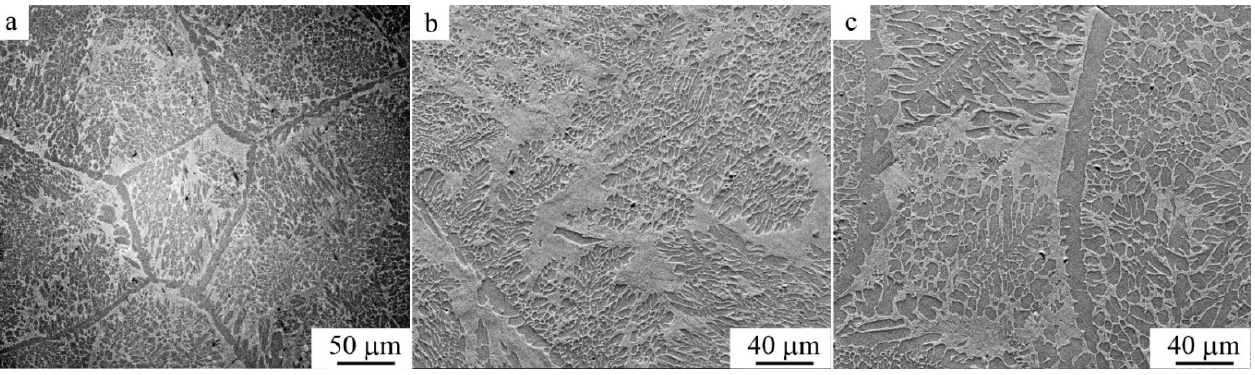
Figure 8. ( а ) OM image of the Cu-14Al-3Ni alloy, SEM images in an EBS mode of the alloys ( b ) Cu- Figure 8. ( a ) OM image of the Cu-14Al-3Ni alloy, SEM images in an EBS mode of the alloys 13Al-3Ni and ( c ) Cu-14Al-3Ni after quenching [46]. ( b ) Cu-13Al-3Ni and ( c ) Cu-14Al-3Ni after quenching